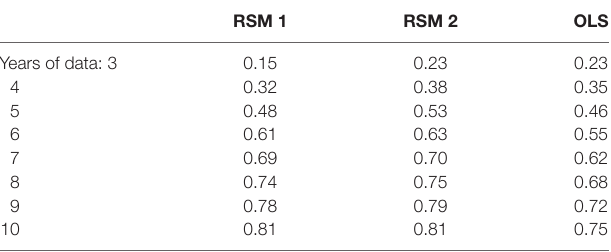
Simulation 2 (negatively skewed). RSM 1 and RSM 2 refer to the multilevel models estimating the correlation between the random variables (1) and fixing it at zero (2).